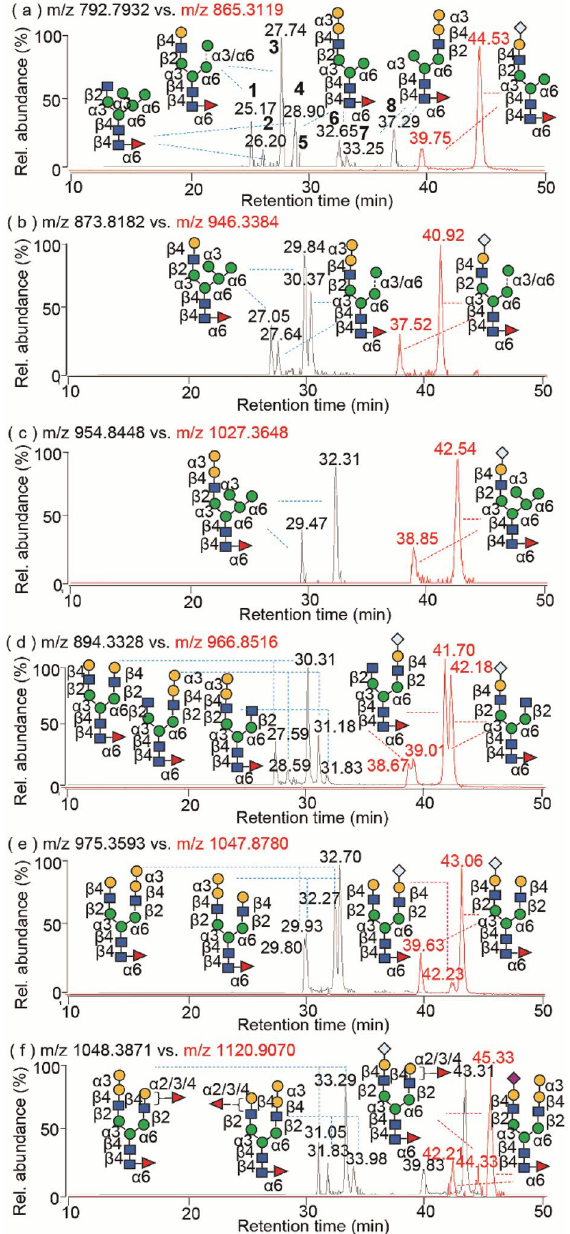
Figure 4. Structural comparison of the non-human glycan isomers between terminal residues of α-Gal and Neu5Gc. ( a – f ) EICs of the typical glycans containing structurally consistent α-Gal (black lines) and Neu5Gc (red lines) at the region-specific locations released from